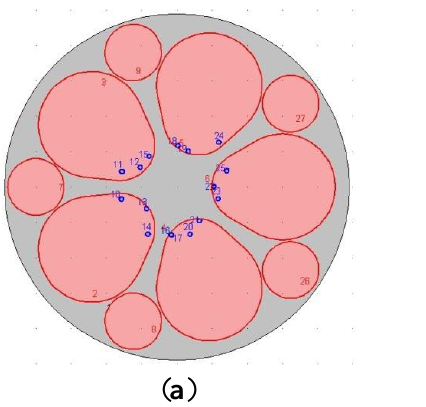
Figure 8. ( a ) The surface plasmon resonance sensors based on grapefruit PCF irregularly filled with three silver nanowires; ( b ) Calculated magnetic field distribution and Im ( n ) = 5.148529e-5i of the guided-mode that can excite and resonant with plasmonic eff modes (the wavelength of the incident light is 649 nm, n